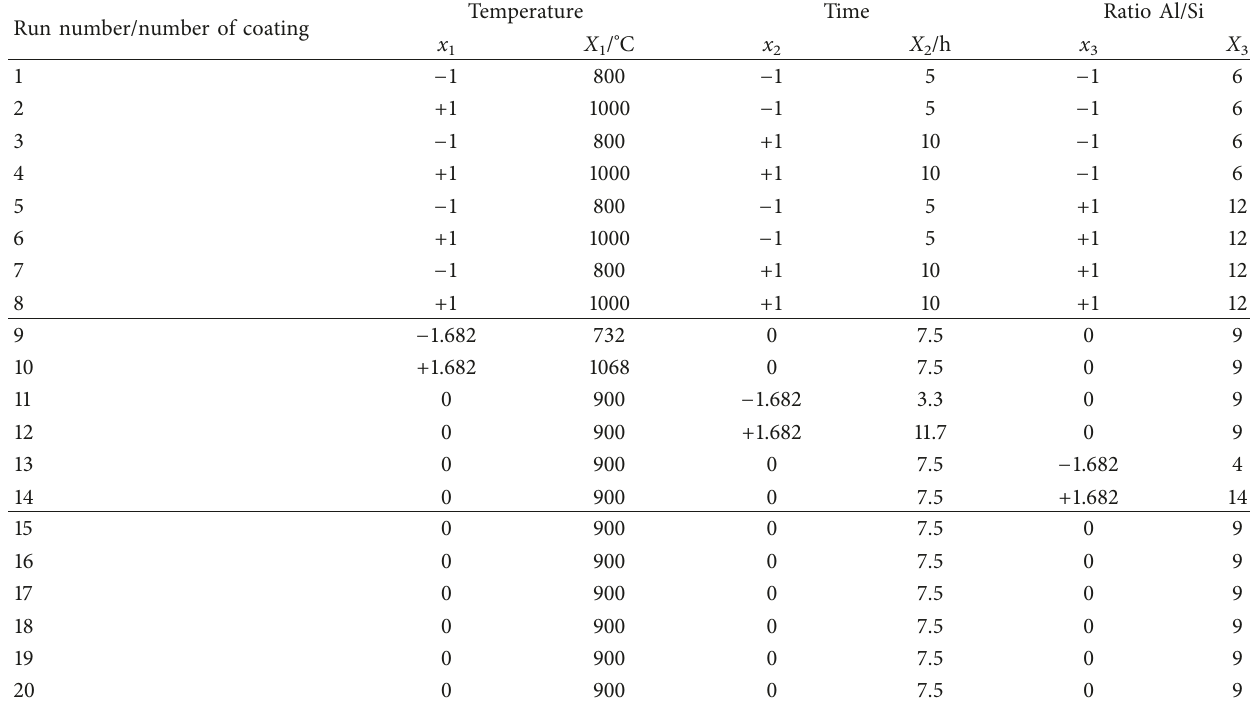
Table 1: The rotatable design for three-factor interactions with coded and real variables.